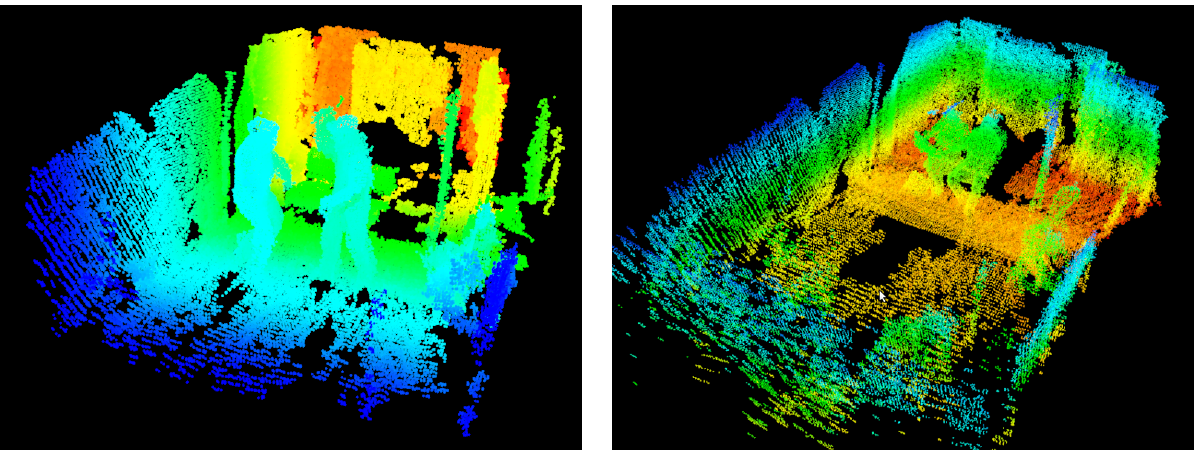
Figure 4: Final result of ICP fusion. Left figures shows two people standing and iteracting whears in the right figure two are sitting and chatting